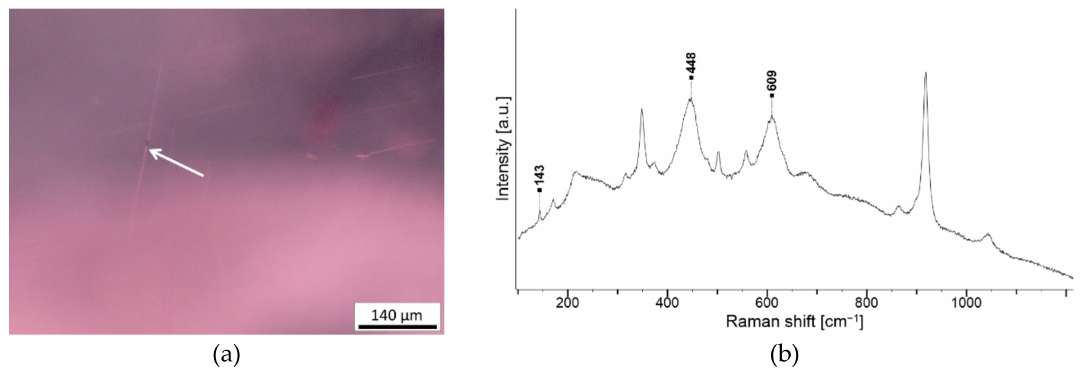
Figure 11. Inclusions in garnet G3 of fibula NA843. ( a ) Needles of rutile. Reflected light, parallel polars; ( b ) Raman spectrum of rutile in almandine